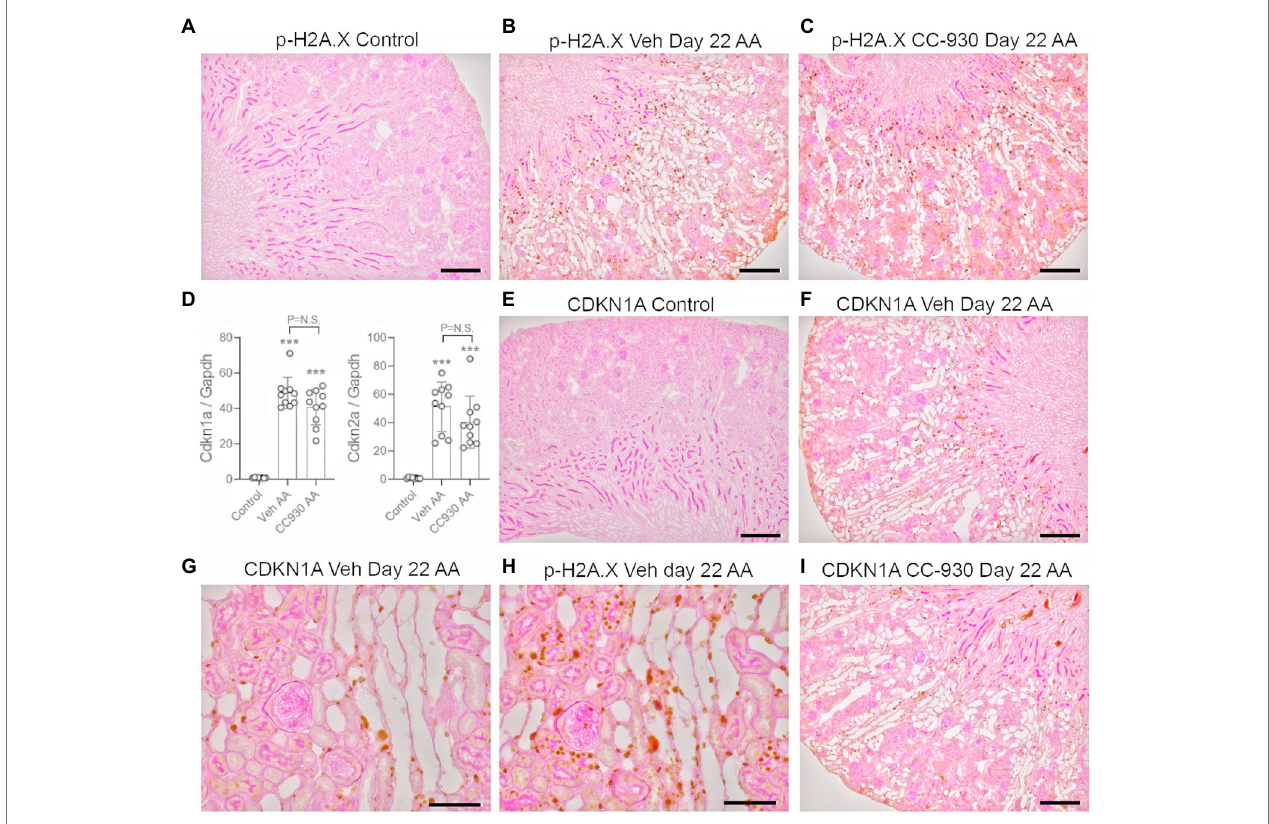
FIGURE 6 | DNA damage (phospho-H2A.X) and senescence markers (CDKN1A) on day 22 of aristolochic acid (AA) induced chronic kidney disease. (A) No staining for p-H2A.X is seen the normal control kidney. (B) Numerous p-H2A.X stained nuclei are seen in vehicle treated day 22 AA, evident in both atrophied and normal tubules. (C) A similar pattern of p-H2A.X nuclear staining is seen in CC-930 treated day 22 AA. (D) RT-PCR analysis of kidney tissue for Cdkn1a and Cdkn2a. (E) No staining for CDKN1A is seen the normal control kidney. (F) Nuclear staining for CDKN1A is evident in cells within atrophied tubules in vehicle treated day 22 AA. (G) Higher power view emphasizes that CDKN1A staining is mostly restricted to damaged tubules. (H) Serial section to (F) showing p-H2A.X staining is also evident damaged tubules, but is more extensive than that of CDKN1A. (I) CDKN1a staining in CC-930 treated day 22 AA is similar to that seen in vehicle treated day 22 AA. Bars represent 200 μ m (A – C,E,F,I) , or 100 μ m (G,H) . One-way ANOVA with Tukey’s multiple comparison test. *** p < 0.001 vs. control; N.S., not